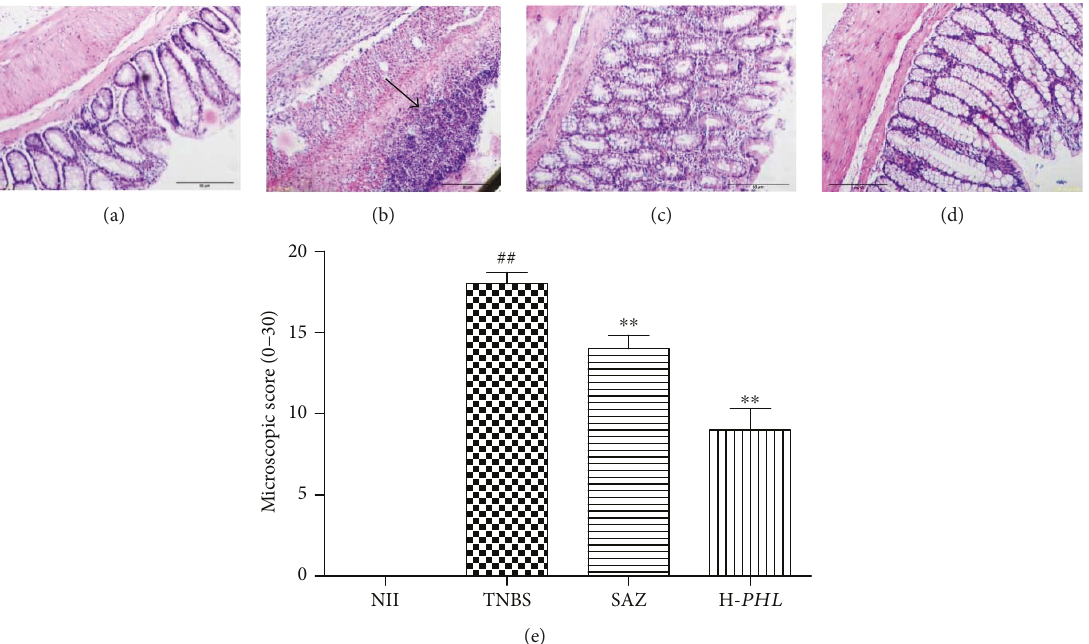
Figure 2: Histological sections of colonic tissue stained with hematoxylin and eosin showing the e ff ects of di ff erent doses of PHL extract and SAZ in TNBS rat intestinal in fl ammation: (a) NII, (b) TNBS-control, (c) SAZ (120mg/kg), (d) H- PHL , and (e) microscopic score. Data are expressed as means ± SEM ( n = 5 ); ∗∗ P < 0 01 versus TNBS; ## P < 0 01 versus